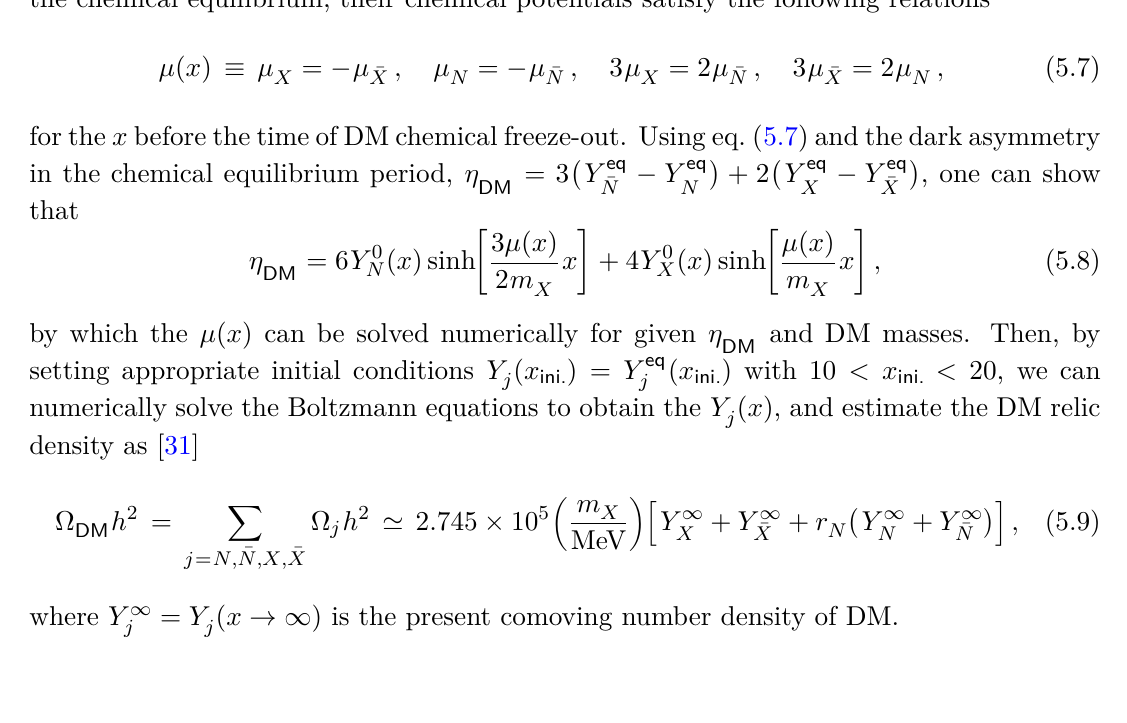
> 1 in the N = 250 MeV, and λ = 2 . 5 in each Z 0 XS